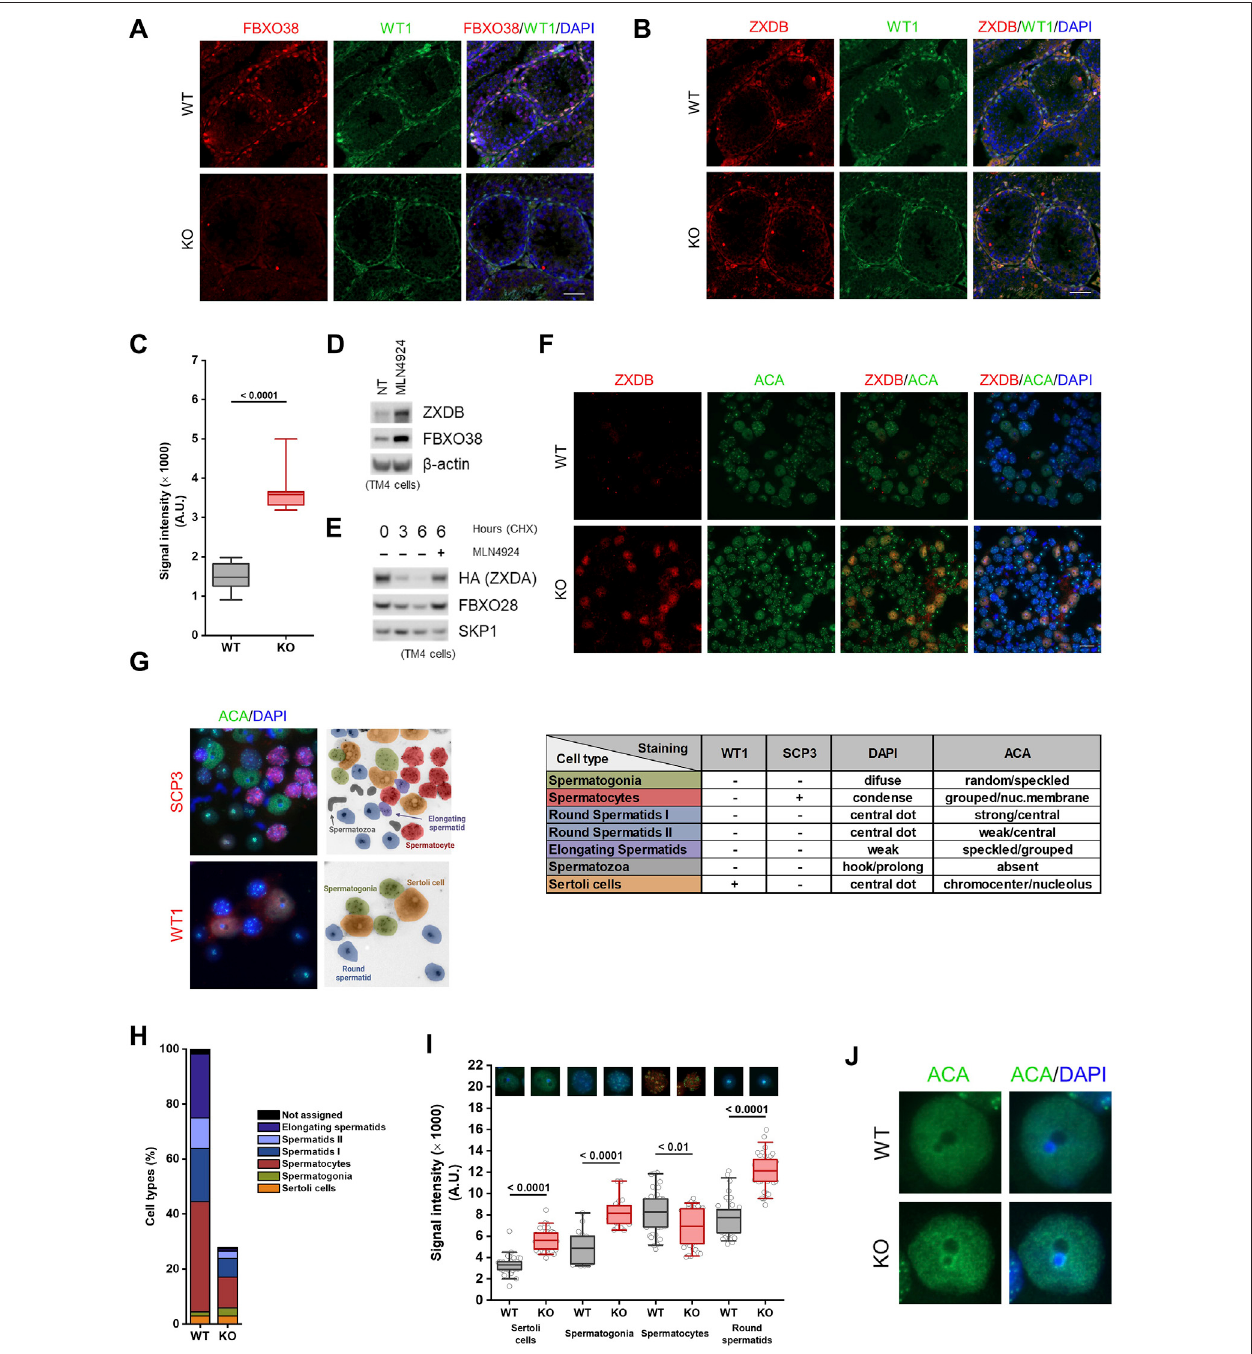
FIGURE 4 | FBXO38 controls ZXDB protein and the centromeric chromatin in adult Sertoli cells. (A,B) Seminiferous tubule sections of young adult (10 weeks old) Fbxo38 wild-type(WT)andknockout(KO)miceco-stainedforWT1andFBXO38(A)orZXDB(B).DNAwasvisualizedwithDAPI.Scalebar,50 µm. (C) Signalintensityof Sertoli cells from testicular sections of Fbxo38 WT and KO stained for ZXDB as in (B). The maximum normalized intensity of cells ( n = 2; 15 Sertoli cells per animal) was measured. Horizontal bars show mean values, boxes represent the 25th and 75th percentiles. Statistical signi fi cance was assessed by an unpaired two-tailed t -test. (D) TM4 cells were either non-treated or treated with MLN4924 for 22 h. Whole-cell lysates were immunoblotted as indicated. (E) TM4 stably expressing HA- tagged ZXDA were subjected to cycloheximide chase. Where indicated, cells were pre-treated with MLN4924 for 1 h. Whole-cell lysates were immunoblotted as indicated. (F) Seminiferous tubule squash from adult Fbxo38 WT and KO mice stained with ZXDB antibody and anti-centromere antibodies (ACA). DNA was visualized with DAPI. Scale bar, 20 µm. (G) Representative images of testicular cell types (from KO animals) and staining for their characteristic markers used to identify the cell populationsinaseminiferoustubulesquash.Themiddleschemeillustratesthepositionandcelltypeshownintheleftpictures.Thetableontherightdepictscombination